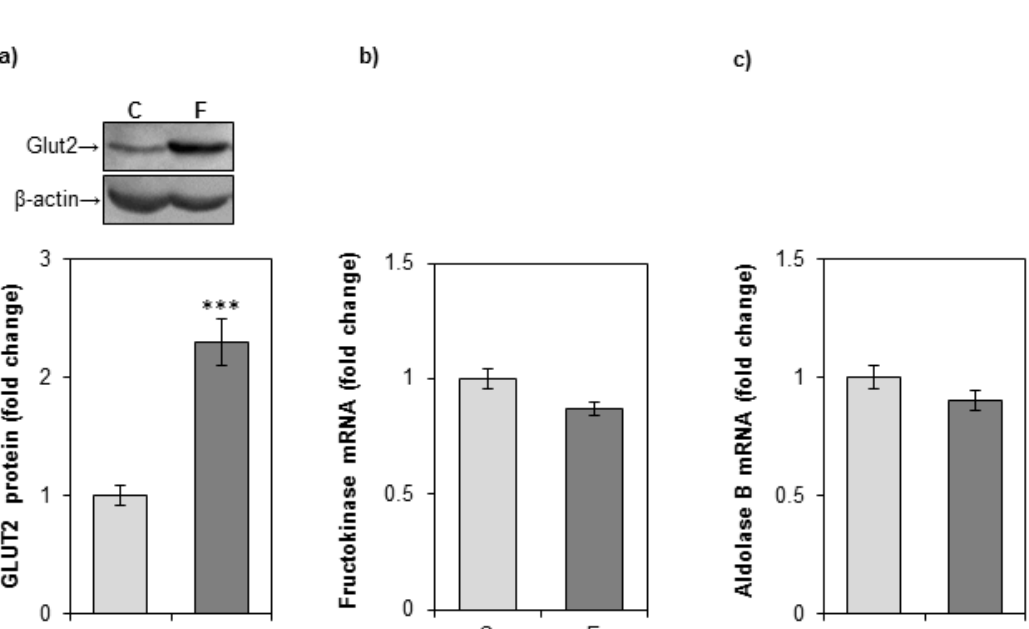
Figure 5. The e ff ects of a fructose-rich diet on the level of GLUT2, fructokinase, and aldolase B in the liver. Groups: control (C), fructose-fed (F). ( a ) GLUT2 protein level in the hepatic whole cell extracts was measured by immunoblotting. Relative integrated optical density of the immunoreactive bands corresponding to GLUT2 was assessed by ImageQuant software, normalized to β -actin, and expressed as fold of the control. Representative Western blot is shown. The level of fructokinase ( b ) and aldolase B ( c ) mRNA relative to β -actin mRNA was determined by SYBR Green real-time PCR and expressed as fold of the control. The values represent the means ± SEM ( n = 9). Statistical significance (Student’s t -test) of di ff erences between experimental groups: *** p < 0.001.